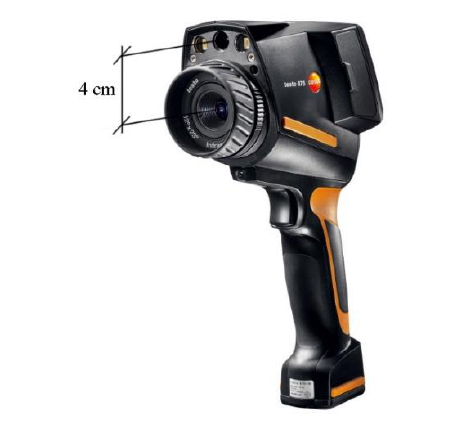
Figure 6. Thermal camera with distance between IR and RGB